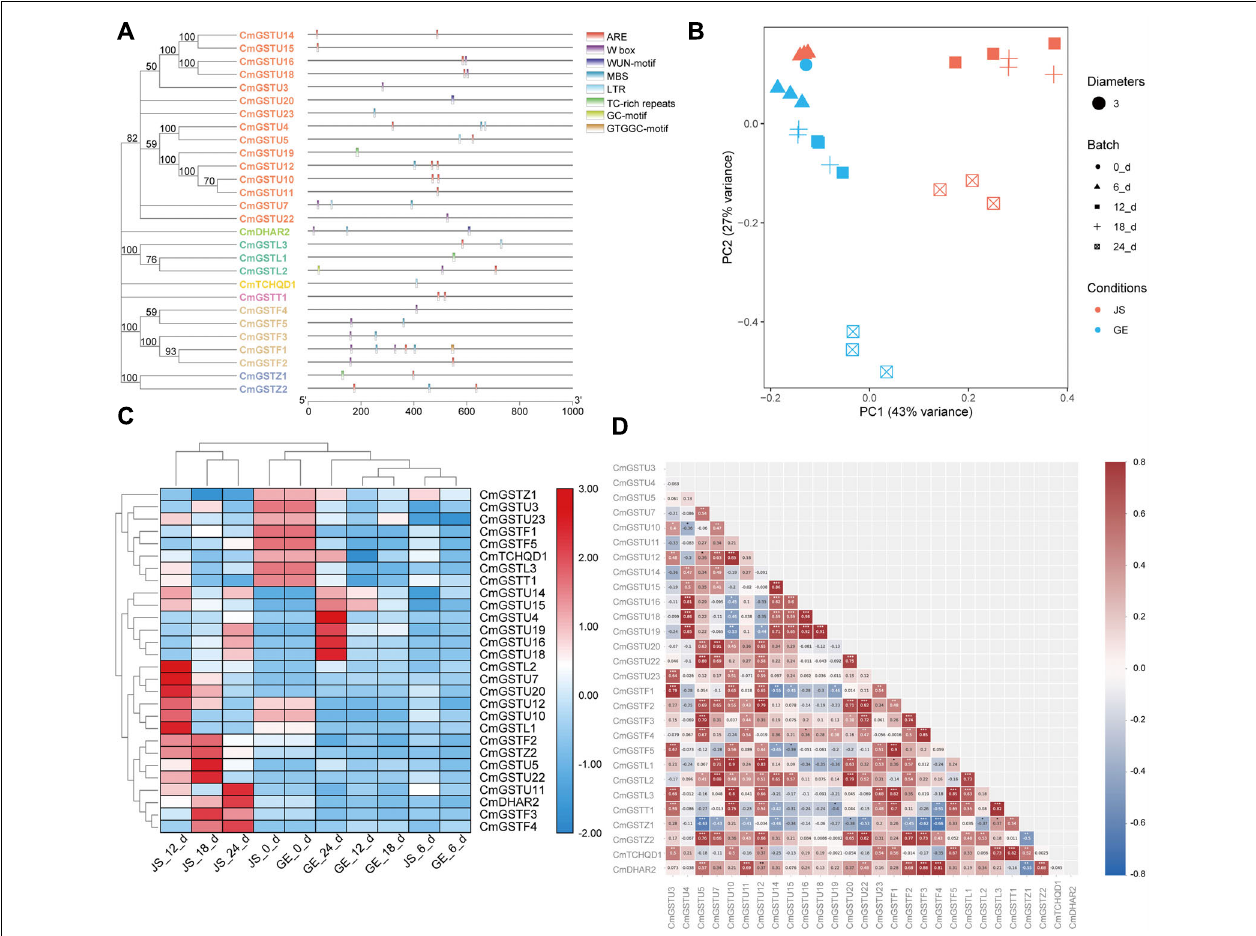
FIGURE 7 | Stress-related CmGSTs in JS and GE of cold treatment. (A) Stress-related cis-elements in CmGSTs promoters. (B) Principal component analysis of stress-related CmGSTs from JS and GE after cold treatment. (C) Hierarchical clustering analysis of stress-related CmGSTs from JS and GE. (D) Correlation analysis of 28 stress-related